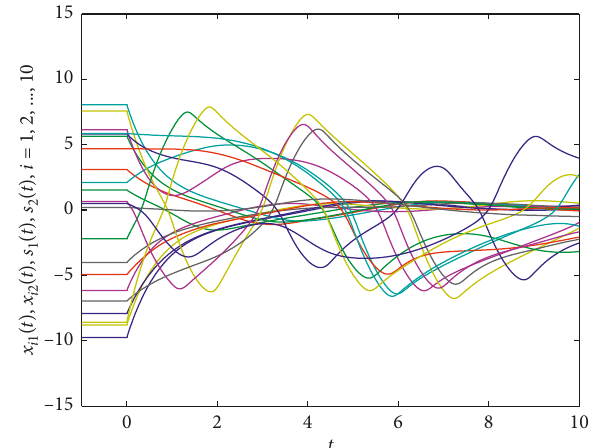
0 Figure 4: Time evolution of nodes’ states x without the control, i � 1 , 2 , .. . , 10.